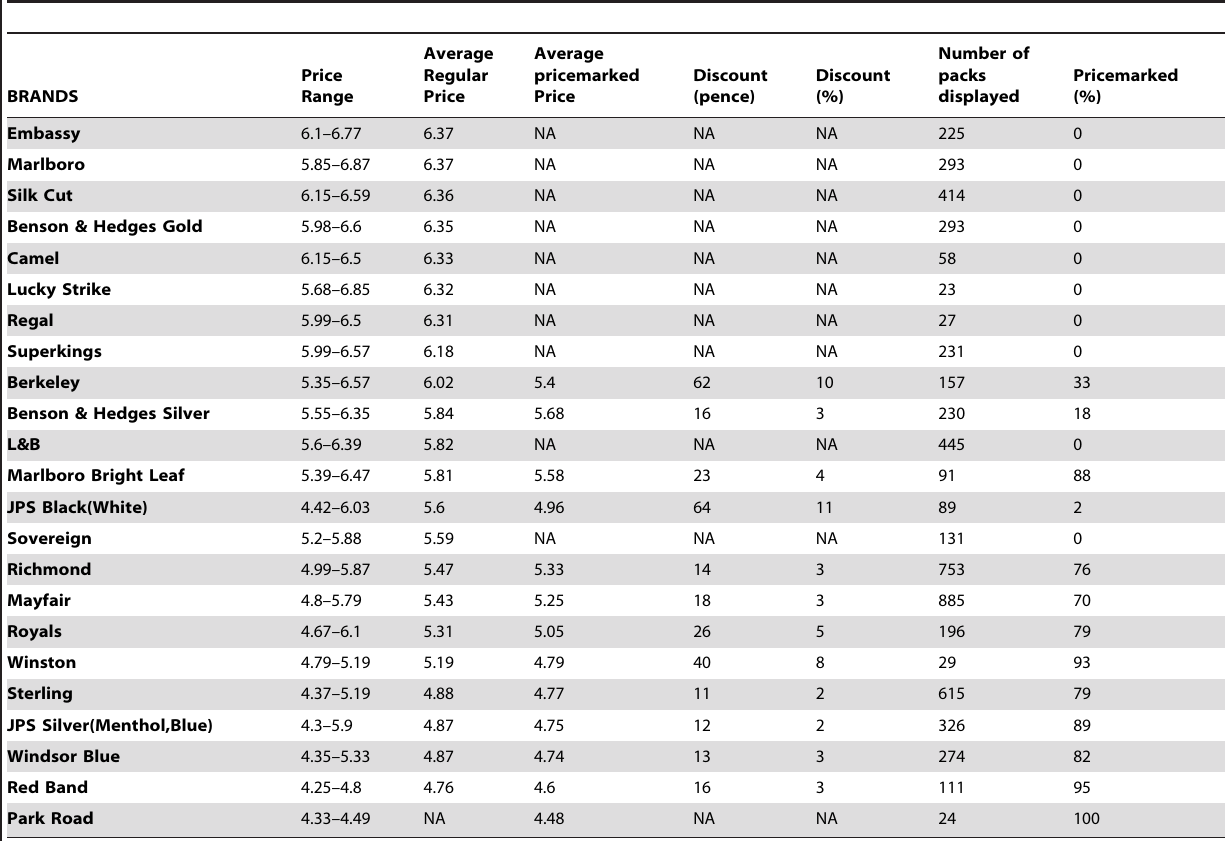
Figure 3. Examples of price-marked cigarette packs. doi:10.1371/journal.pone.0029871.g003 Table 1. Price ranges, average undiscounted and pricemarked price, discount in pence and as a percent of undiscounted price, number of packs on display and the proportion of pricemarked packs for the most commonly displayed 20-pack brands or similarly priced brand variants, ranked in descending undiscounted price order (NA =not available or not